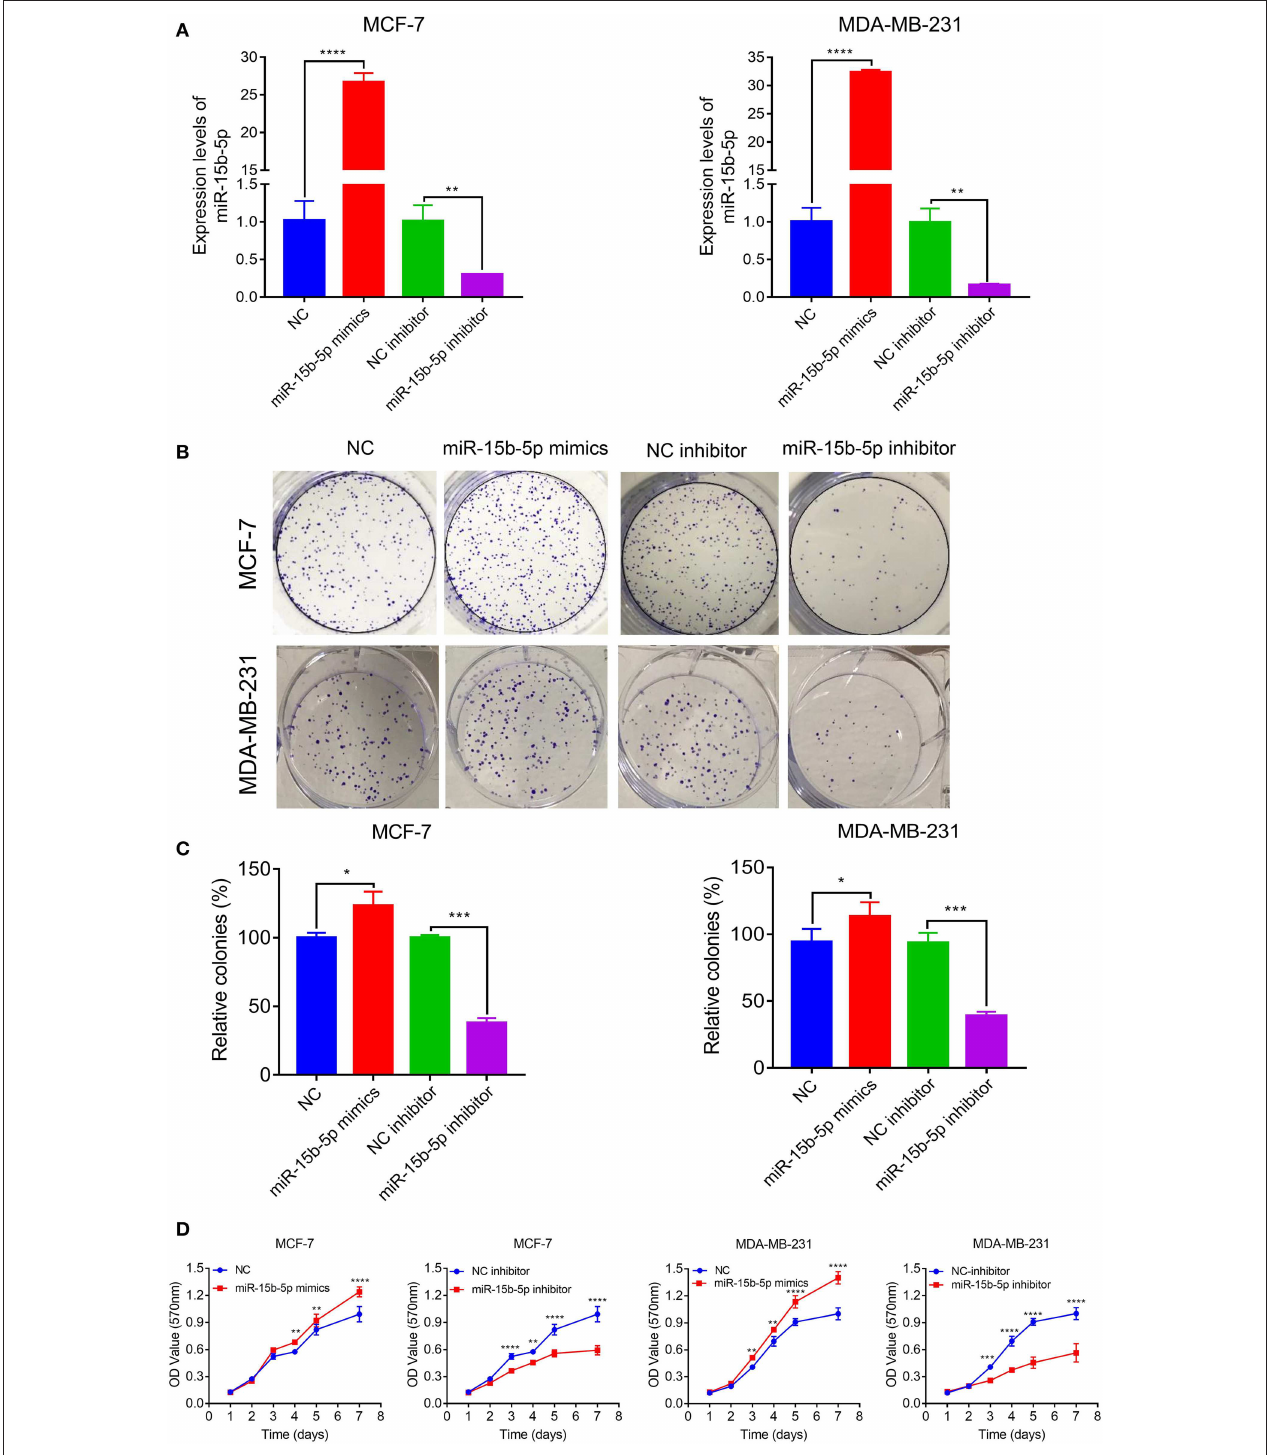
FIGURE 3 | miR-15b-5p promotes breast cancer (BC) cell proliferation. (A) Detection of transfection efficiency by qPCR. U6 served as an internal control. (B,C) Colony formation assays demonstrated that miR-15b-5p promoted clone formation in BC cell lines following transfection with the miR-15b-5p mimic when compared with negative control (NC). miR-15b-5p inhibited colony formation in BC cell lines following transfection with the miR-15b-5p inhibitor when compared with the inhibitor NC. (D) 3-(4,5-Dimethylthiazol-2-yl)-2,5-diphenyltetrazolium bromide (MTT) assay revealed that miR-15b-5p promoted the proliferation of BC cell lines following transfection with the miR-15b-5p mimic when compared with NC, while miR-15b-5p significantly decreased the proliferation of BC cell lines following transfection with the miR-15b-5p inhibitor as compared with the inhibitor NC (* P < 0.05, ** P < 0.01, *** P < 0.001, and **** P < 0.0001).